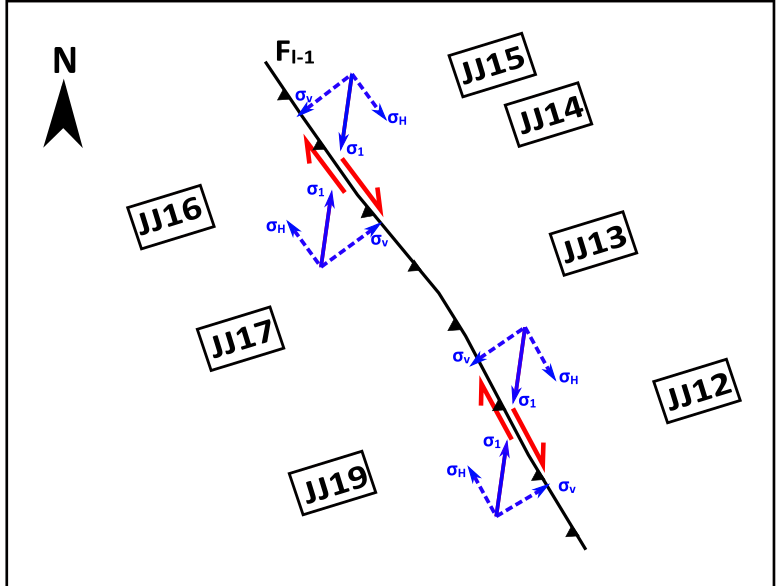
Figure 13. A schematic figure illustrating the direction of maximum compression ( σ 1 ) and the two components ( σ V and σ H ) along F l-1 . This relationship leads to dextral slip along the fault plane, so that JJ12 to JJ15 are displacing towards the southeast.